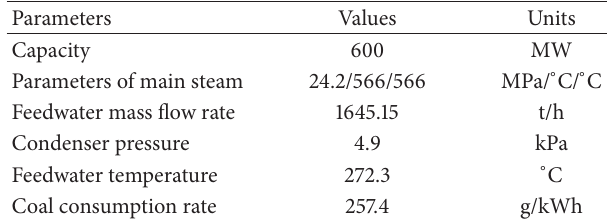
Table 1: Main designed parameters of coal-fired power